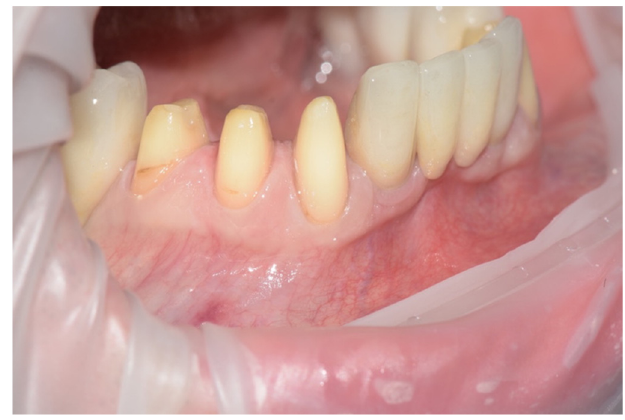
Figure 2. Preparation of the abutments (teeth #43, #44, #45).